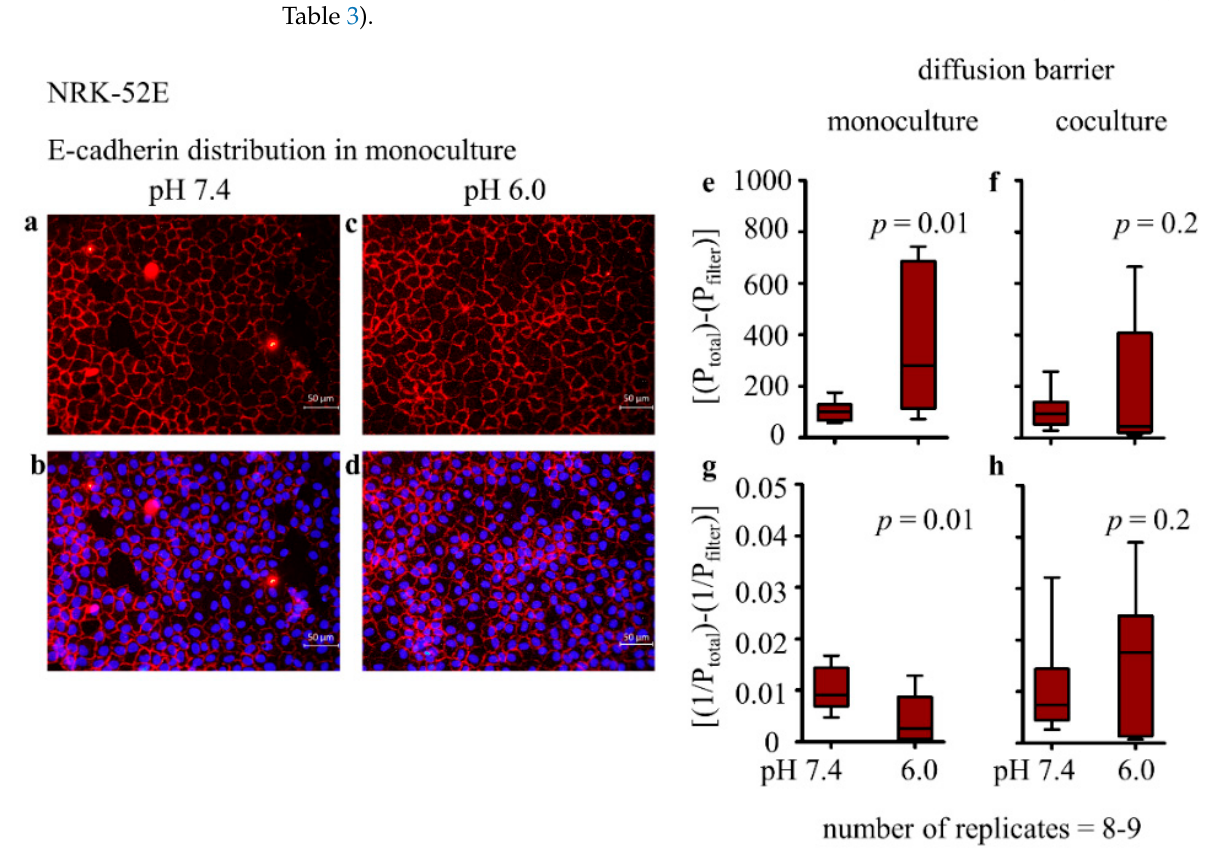
Figure 2. Impact of acidosis on E-cadherin distribution in NRK-52E in monoculture. ( a – d ) n − (24). Acidosis effect on barrier function of NRK-52E cells in mono-and co-culture ( e – h ). n − (9); exposure time = 48 h. p < 0.05 at significant difference compared with the control group. Table 3. Cytosolic E-cadherin and cell morphology.